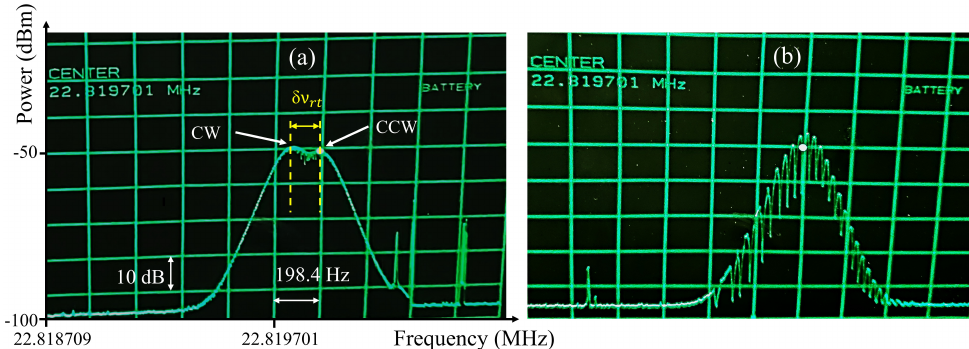
Figure 4. Radio frequency spectrum of the pulse trains in opposite directions of the cross-polarized fiber laser with ( a ) different and ( b ) the same repetition rates. The scales on the x and y axes are the same in both graphs. CW: clockwise, CCW: counter-clockwise, bandwidth resolution: 100 Hz.